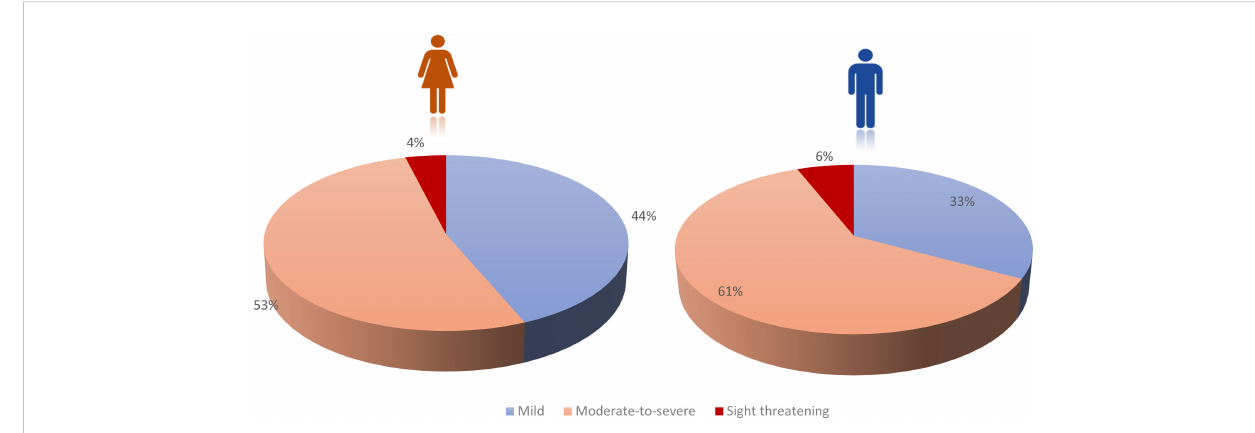
FIGURE 1 Mild, Moderate-to-severe and Sight-threatening GO in female (n=3502) and male patients (n=758) in a tertiary referral